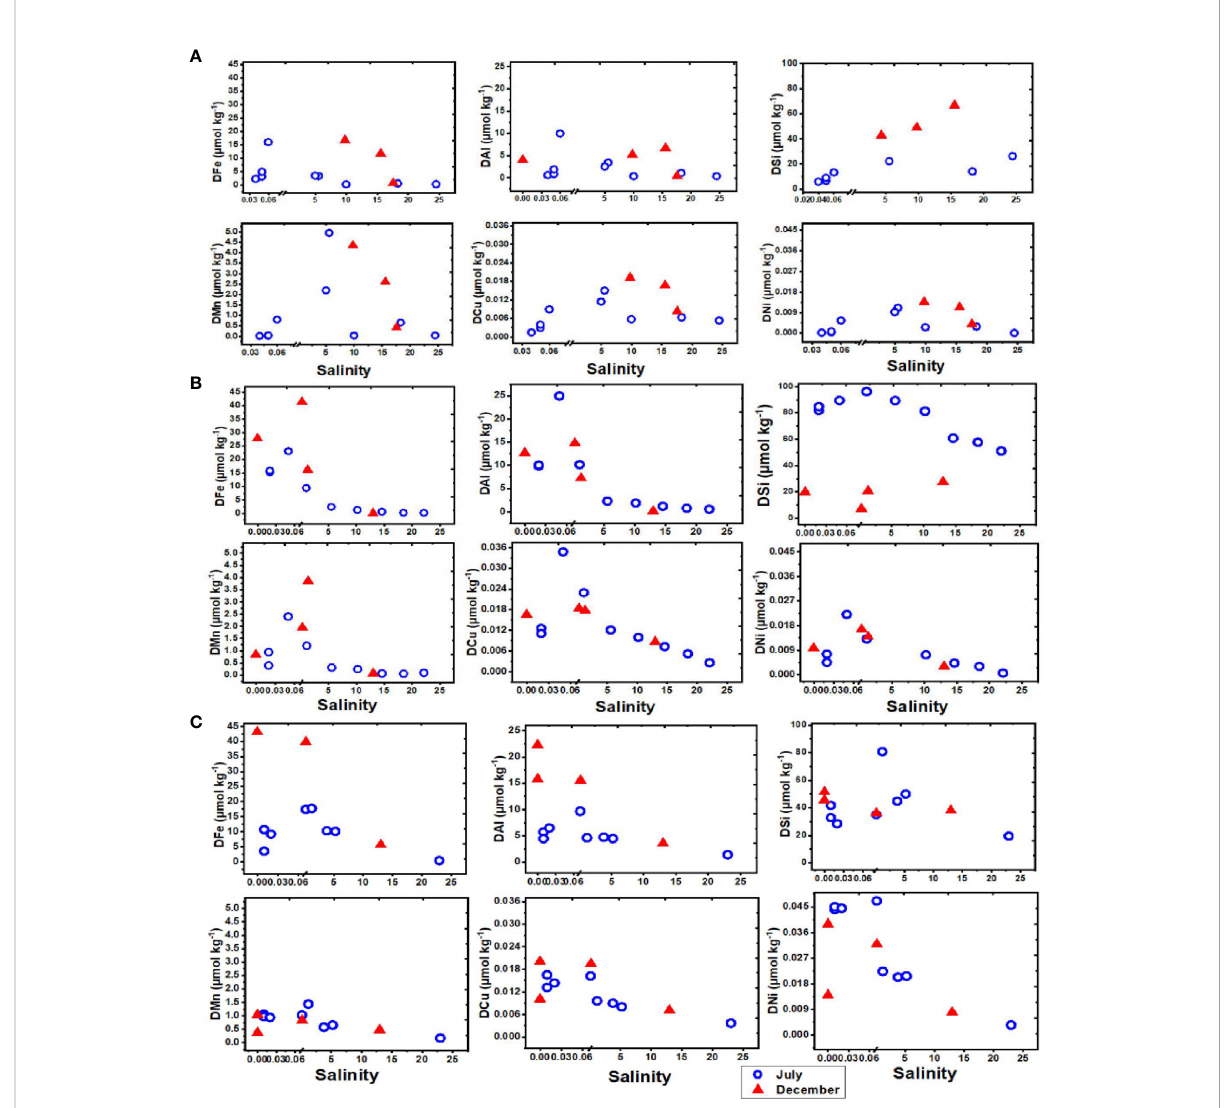
FIGURE 3 Dissolved elements as a function of salinity in the blackwater rivers and estuaries of Borneo in July (dry) and December (wet), 2019. Each plot shows the distribution of elements (Fe, Al, Si, Mn, Cu and Ni) in (A) Maludam (B) Sebuyau (C) Belait rivers and